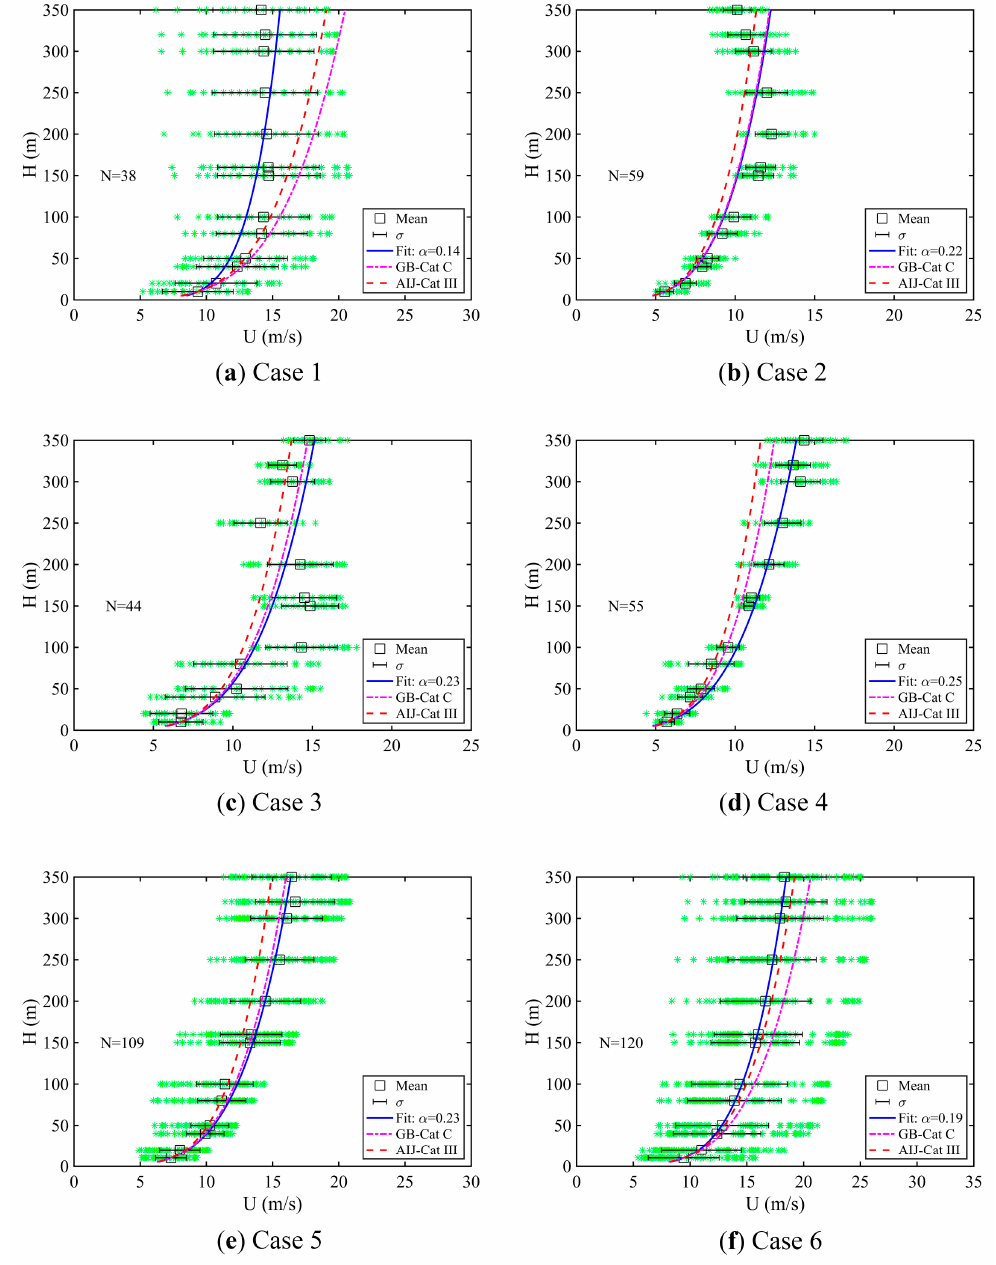
Figure 4. Wind profiles of each individual event, total = 6. N refers to number of samples.